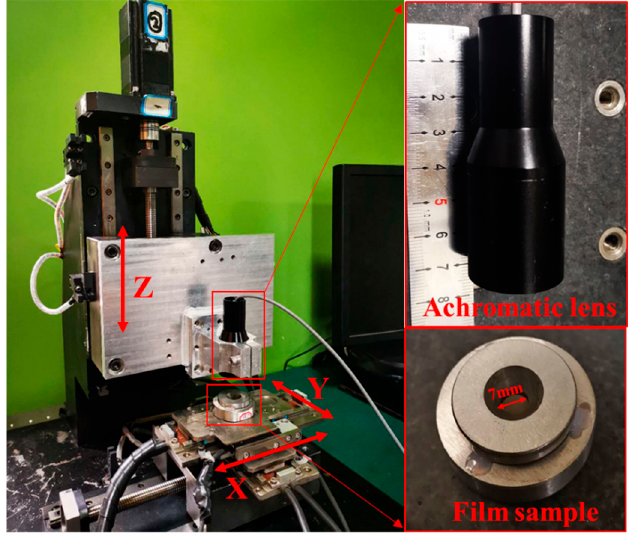
Figure 9. Experimental measurement system setup.